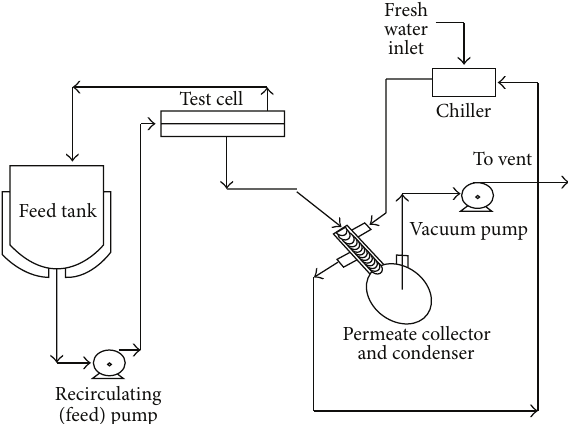
Figure 2: Typical diagram of pervaporation reactor